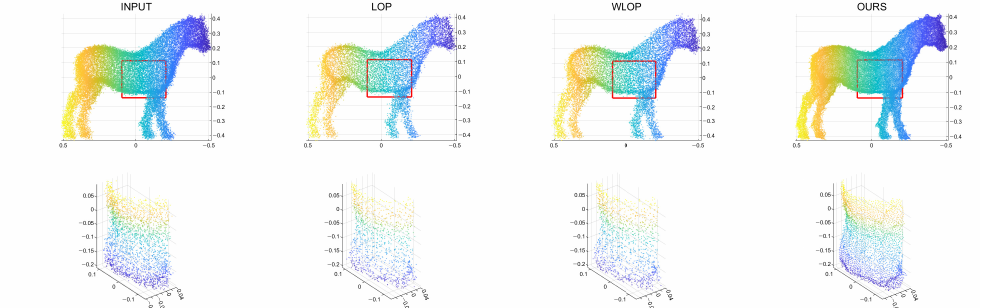
Figure 17. Qualitative results for an omnidirectional noise case with resampling ratio 2.0 (Horse). First column: input point cloud; second column: LOP; third column: WLOP; and fourth column: the proposed method. The second row shows enlarged views of the first